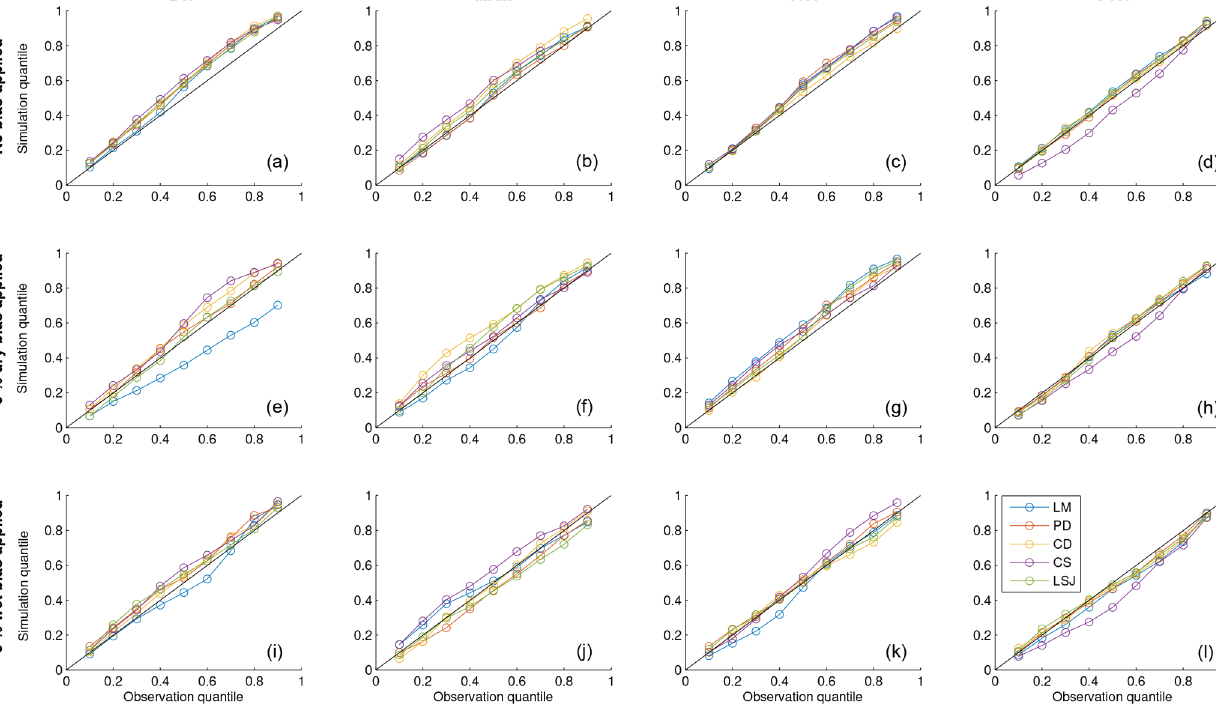
Figure 4. Reliability diagrams for seasonal forecasts. Panels (a–d) present the results for the original forecasts, panels (e–h) contain a 5% dry bias and panels (i–l) include a 5% wet